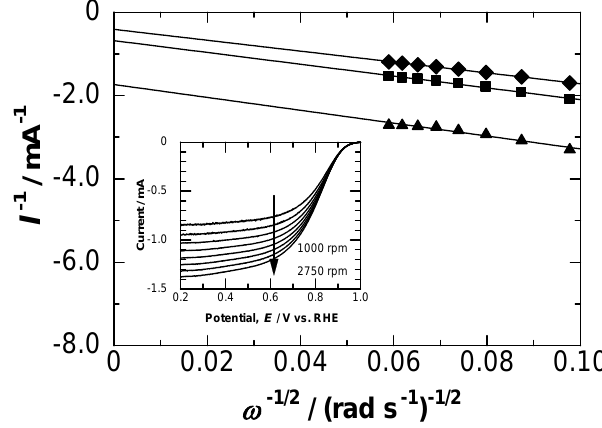
Figure 7. Koutecky-Levich plots obtained from hydrodynamic voltammograms for the ORR (shown in the inset) at ( ▲ ) 0.85 V, ( ● ) 0.80 V and ( ♦ ) 0.76 V vs. RHE at Nafion-coated Pt/TiC-600 °C electrode in O 2 -saturated 0.1 M HClO 4 solution at 25